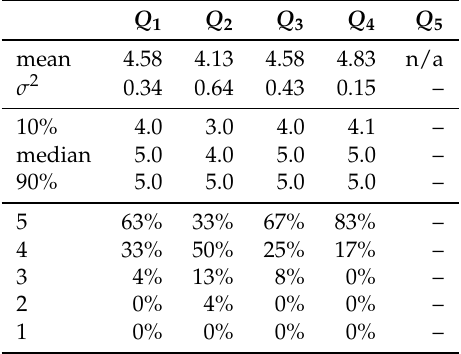
Table 6. Results from the questions Q 1 ... Q 4 , showing mean, standard deviation, 10% percentile, median, 90% percentile and percentages for the respective values of the Likert-scale Q